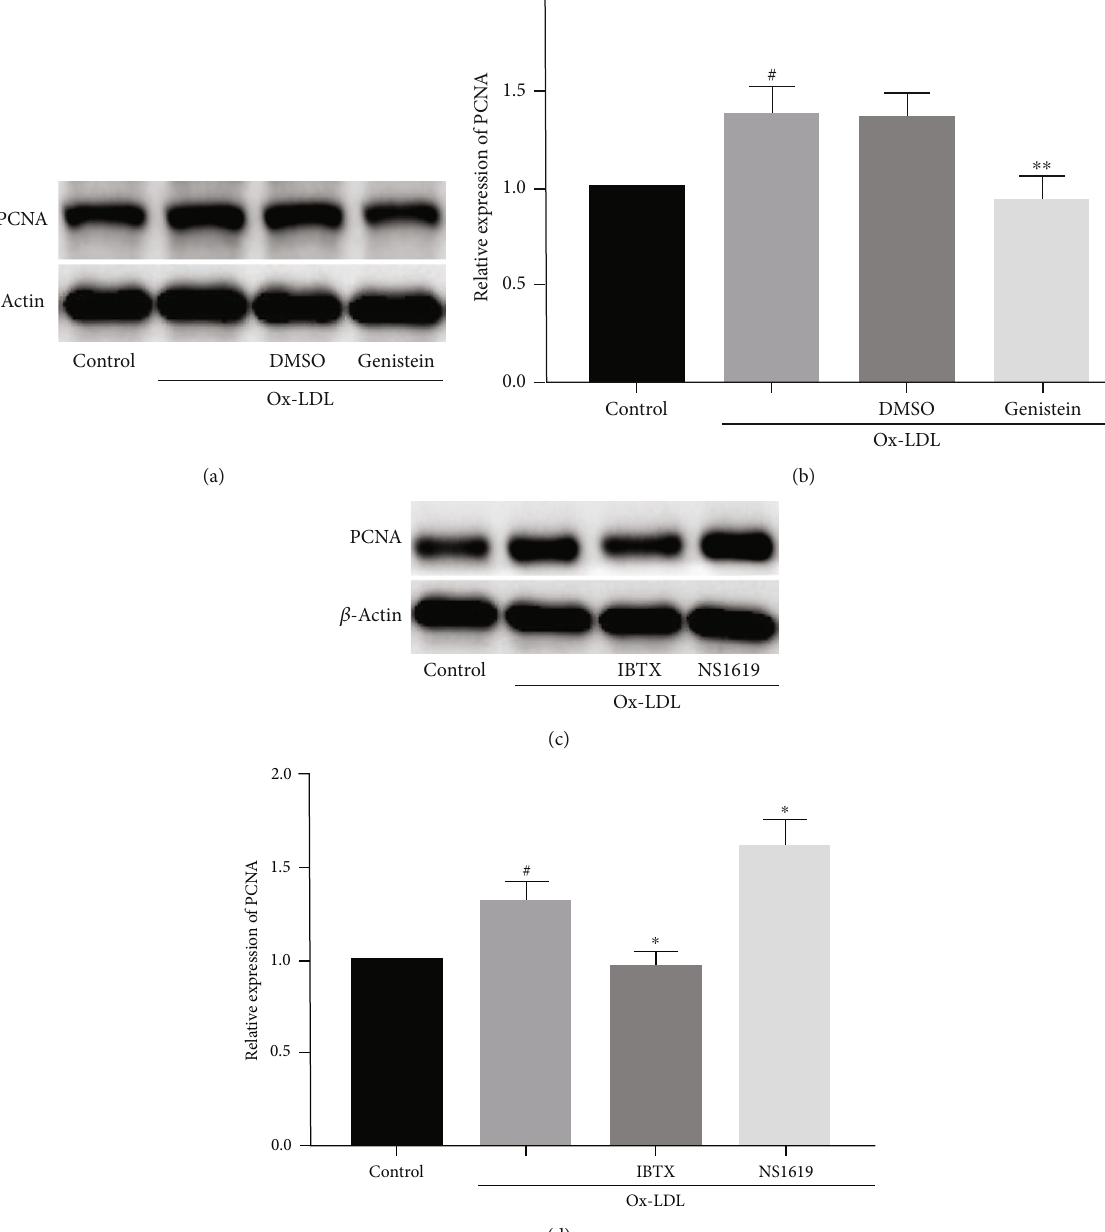
Figure 2: The e ff ect of genistein and BKCa channels on PCNA expression. (a, b) Ox-LDL enhanced the expression of PCNA while genistein reversed this e ff ect. DMSO had no signi fi cant e ff ect. (c, d) The expression of PCNA was upregulated by NS1619 and downregulated by IBTX. # P < 0 : 05 vs. control, ∗ P < 0 : 05 and ∗∗ P < 0 : 01 vs. Ox-LDL. All the results are expressed as the mean ± SD ( n = 3 per